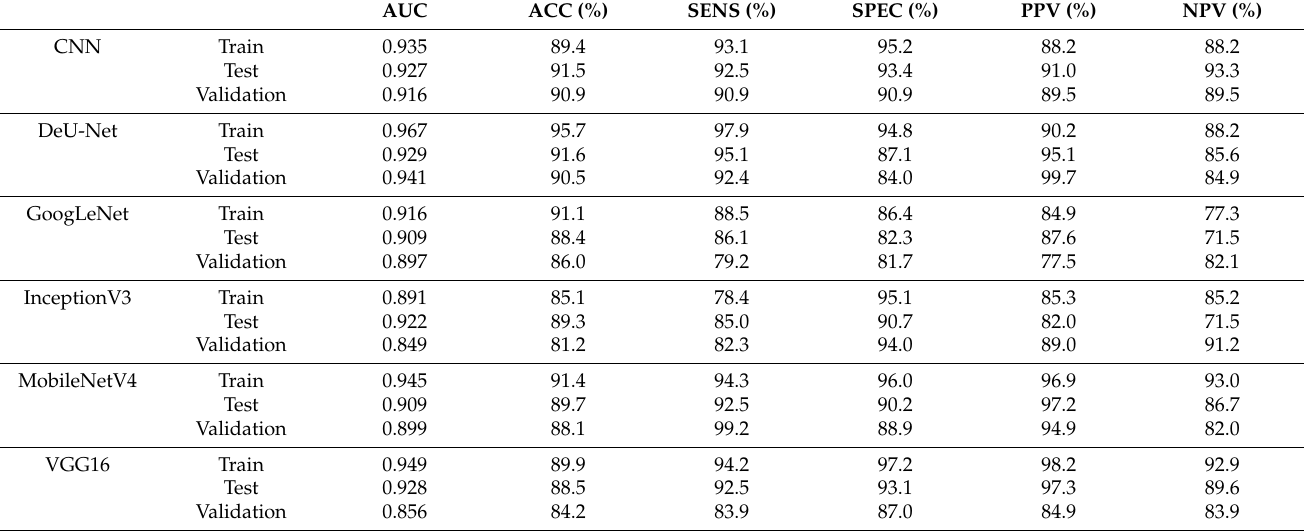
Table 7. Performance of different neural network in training with fusion images.